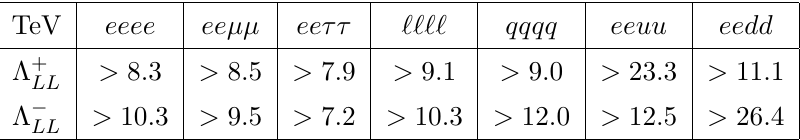
Table 1 . Four Fermi contact interaction bounds in TeV from PDG (2016)